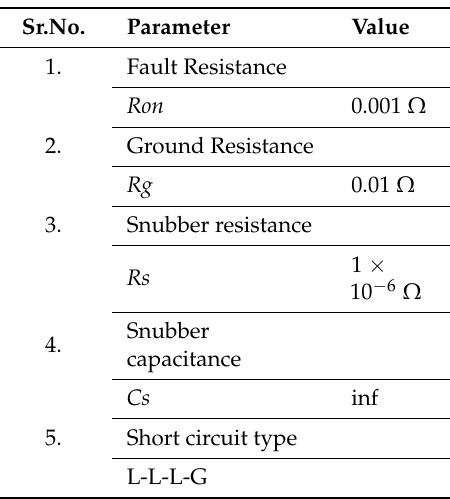
Table 4. Short Circuit Fault